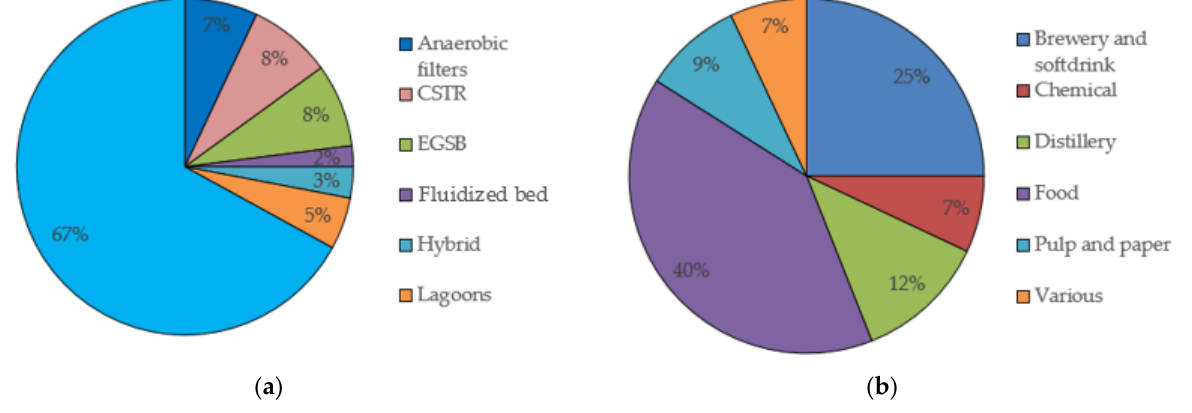
Figure 2. Types ( a ) and applications ( b ) of anaerobic reactors.